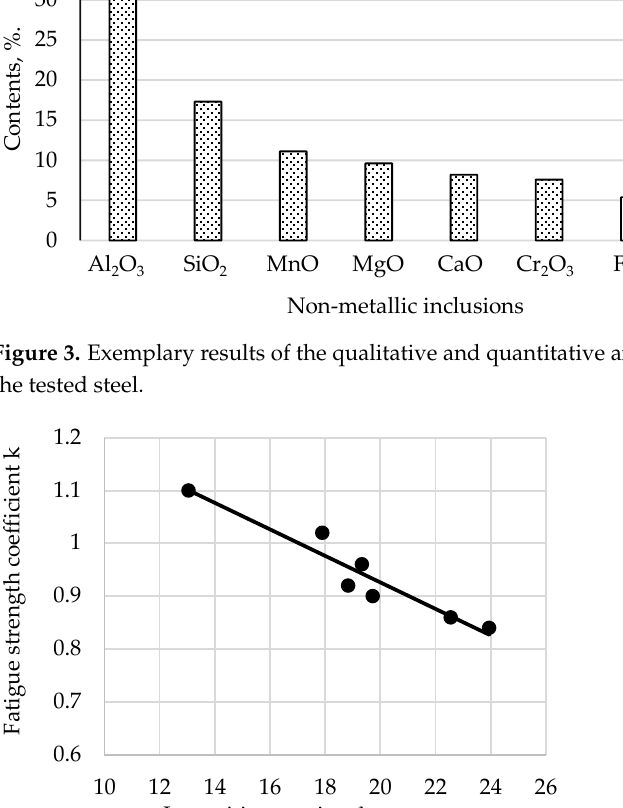
Figure 4. Fatigue strength coefficient, k , of tested steel after hardening from 880 ◦ C and tempering at